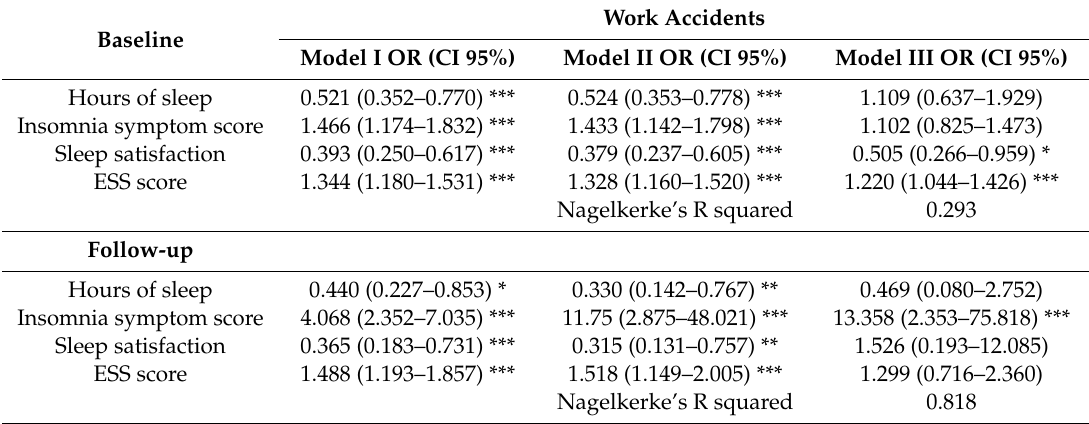
Table 5. Logistic regression analysis. Univariate association of sleep variables with work accidents in police o ffi cers, in 2015 and